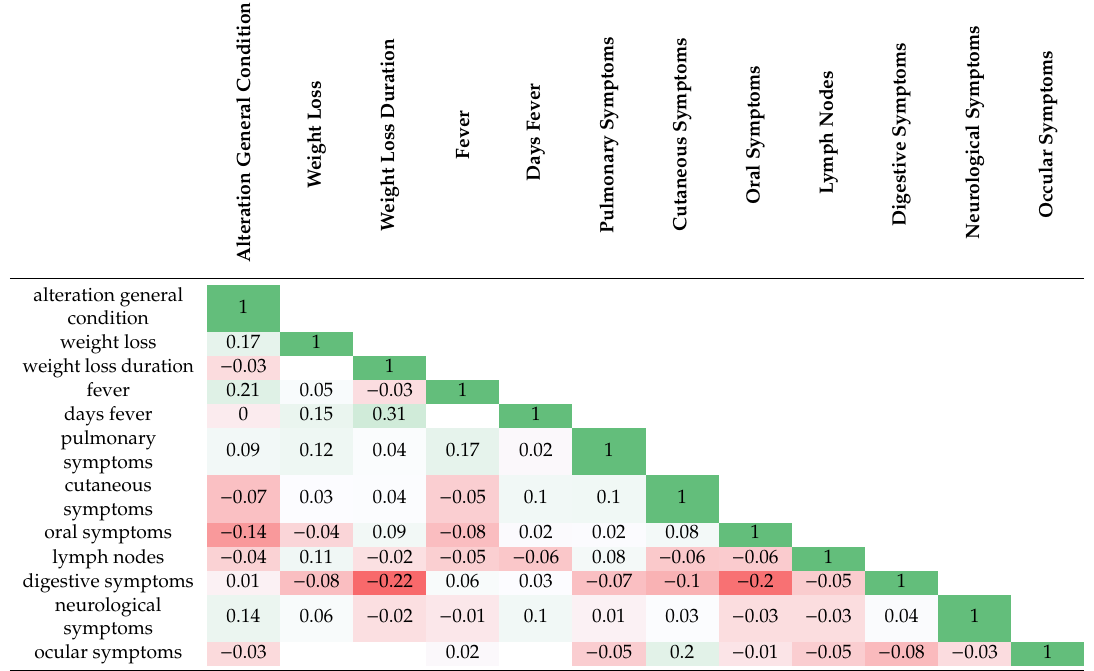
Table 4. Pairwise correlation matrix di ff erent signs and symptoms leading to the current hospitalization.